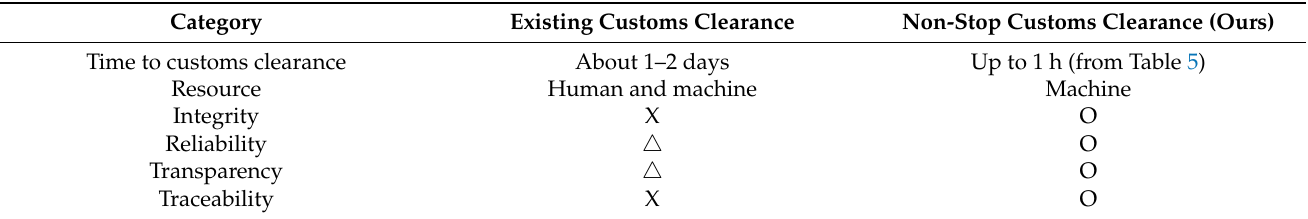
Table 6. Quantitative comparison of the existing customs clearance system and